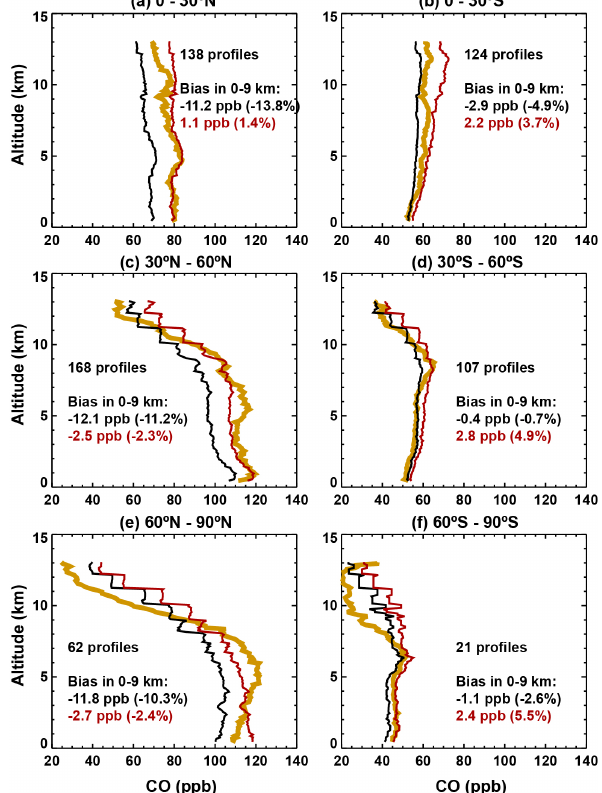
Figure 9. Measured and simulated vertical profiles of CO at 0.1km intervals averaged across all HIPPO campaigns at the six latitude bands of 30 ◦ width. Model results are sampled at times and loca- tions coincident to HIPPO measurements. Also shown are the num- ber of profiles and mean model biases below 9km (with abundant measurements) at each